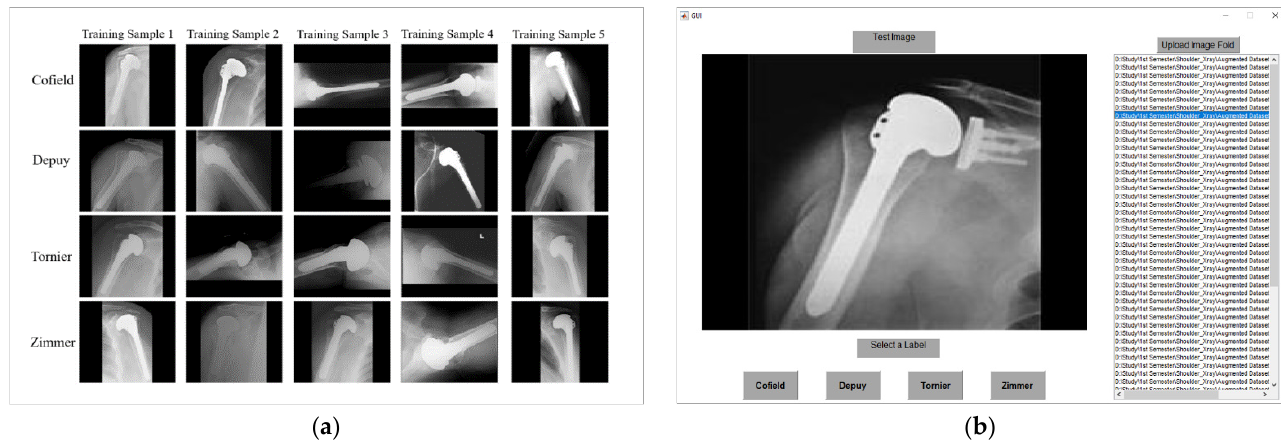
Figure 11. Graphical user interface used for subjective evaluation ( a ) random training samples of each class, which are shown to user during subjective evaluation, ( b ) interface showing all the testing data samples to user one by one for subjective class prediction. Table 9. Demographic details of different subjects and their subjective evaluation results.